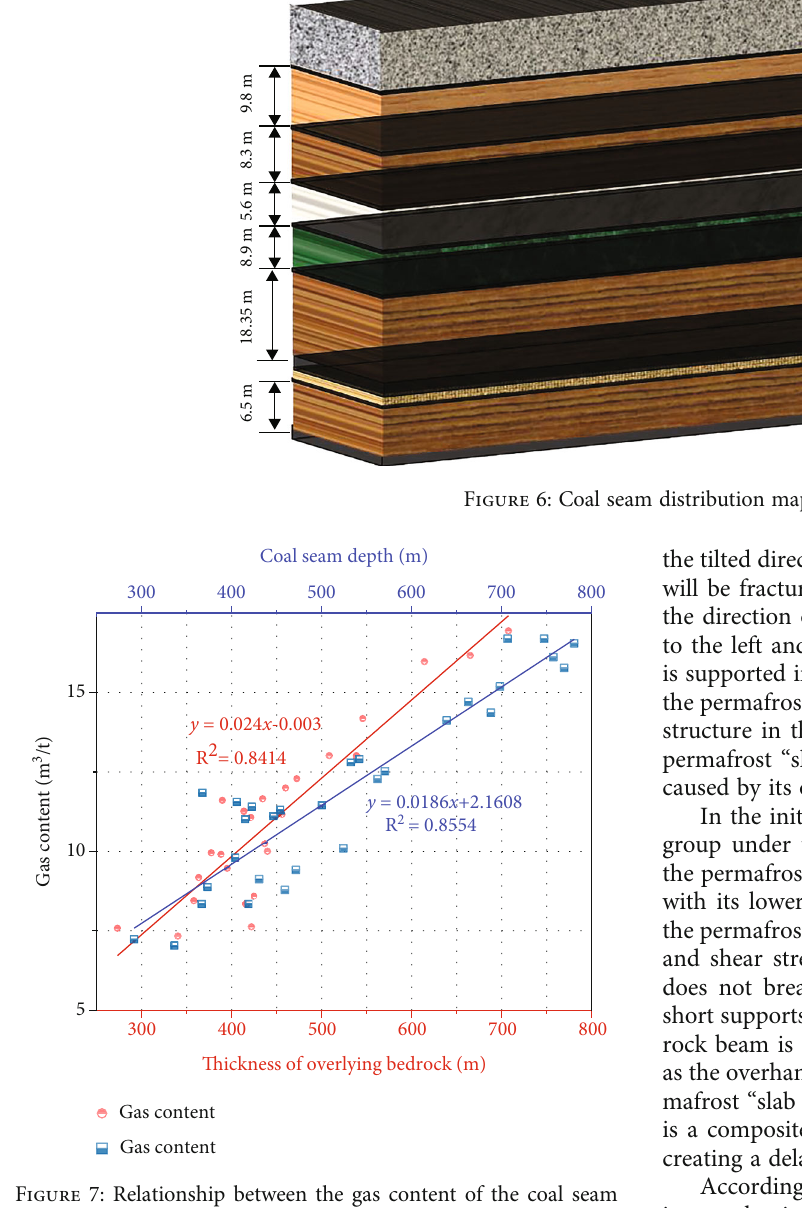
Figure 7: Relationship between the gas content of the coal seam and the thickness of the overlying bedrock and depth of burial of the coal